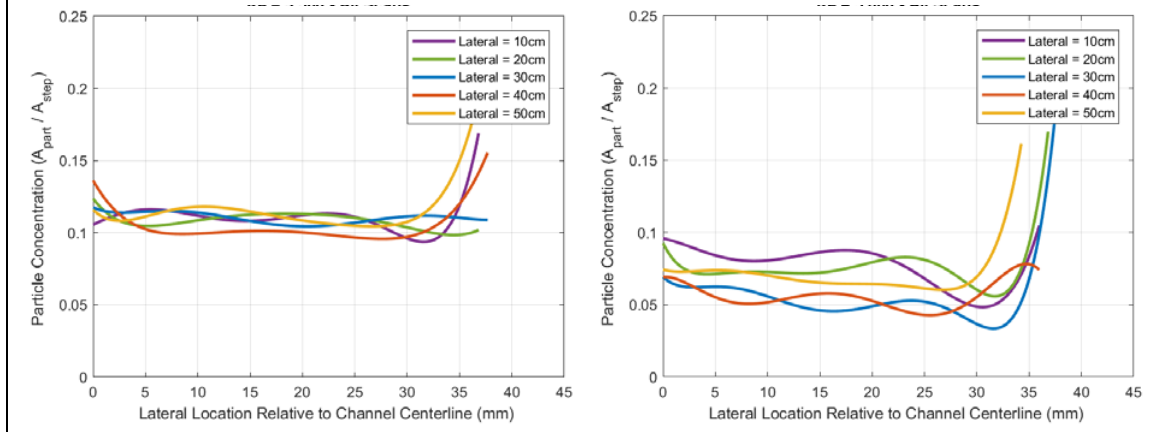
Figure 6. Lateral Particle Distribution (Left) Re